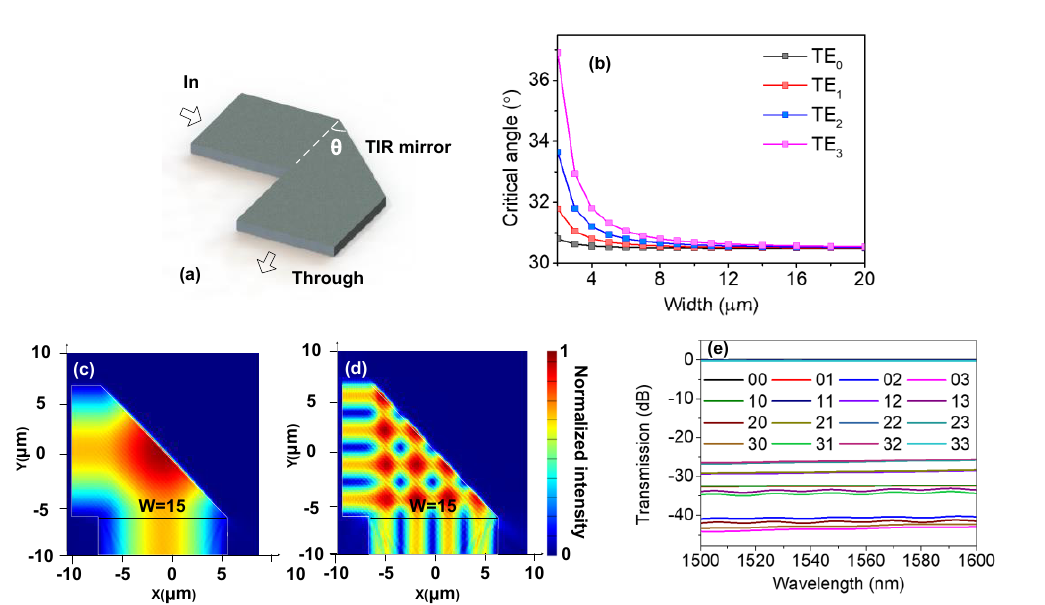
Figure 3: (a) Structure of the 90 ° bend with TIR. (b) Simulated critical angle for TE 0 – TE 3 modes with different waveguide widths at 1550 nm. Simulatedlightpropagationsfor(c)TE 0 and(d)TE 3 modeinputandcorrespondingtransmissionspectrafor(e)TE 0 and(f)TE 3 modeinputfrom 1500 to 1600 nm. In the legend “ 01 ” , “ 0 ” stands for the input TE 0 mode, while “ 1 ” stands for the output TE 1